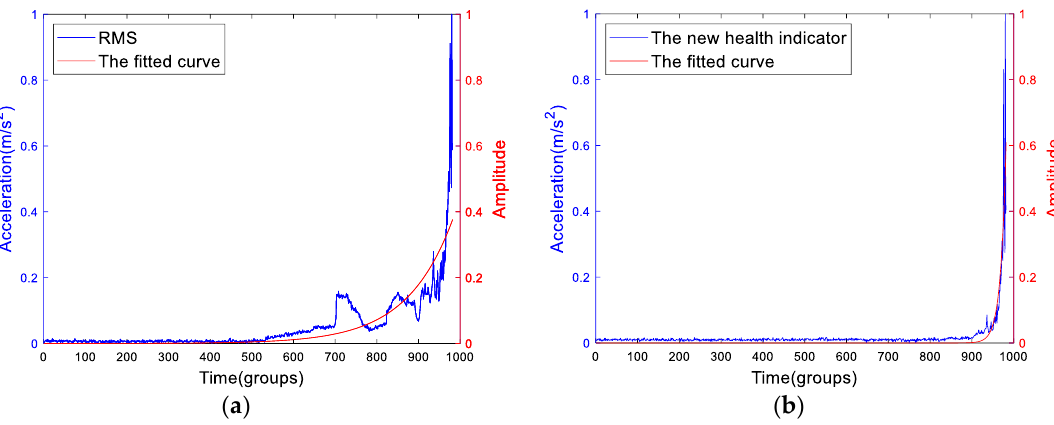
Figure 19. The smoothed and normalized RMS and the proposed indicator. The ( a ) normalized RMS and ( b ) the normalized new health indicator and their fitted